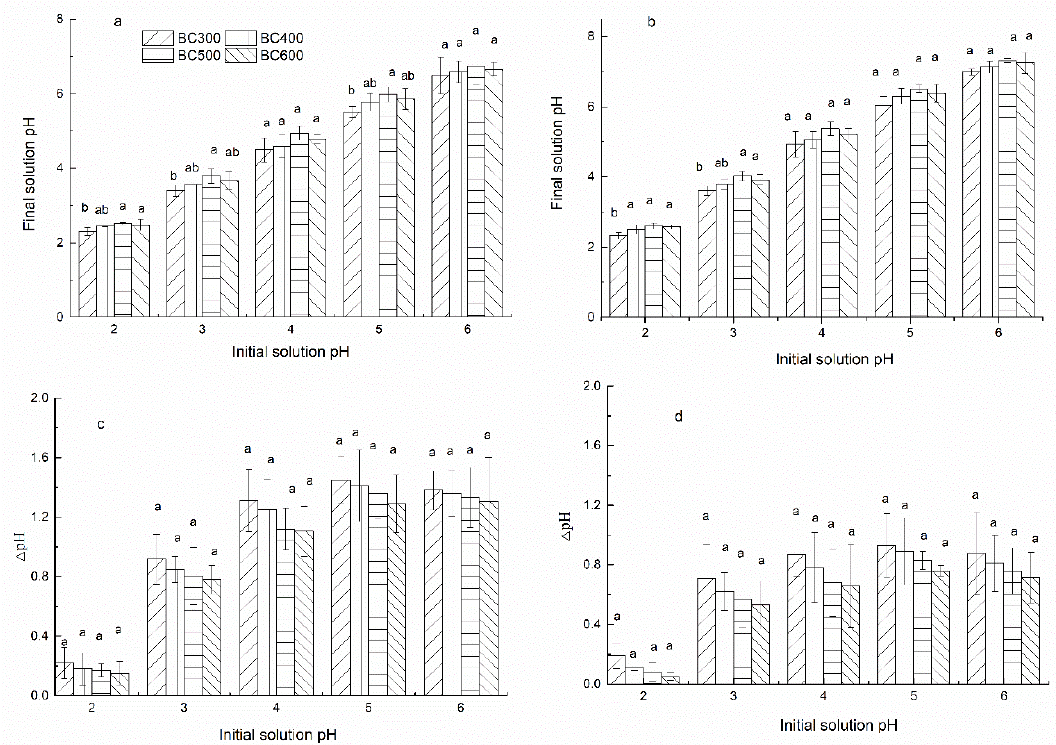
Figure 3. Zeta potentials of BC300, BC400, BC500, and BC600 at different pH values. Error bars represent standard error ( n = 3). LSD is the least significant difference at p < 0.05 under the same pH.